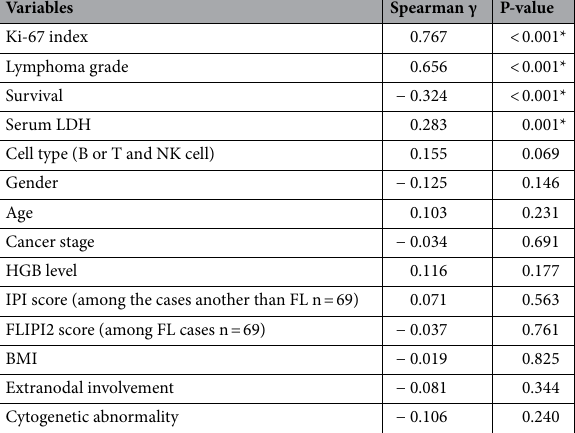
Table 4. Correlation between the LAT1 and other variables by Spearman’s rank test. BMI, bone marrow involvement; HGB, hemoglobin; Serum LDH, serum lactate dehydrogenase. *P-value < 0.05 indicates a significant